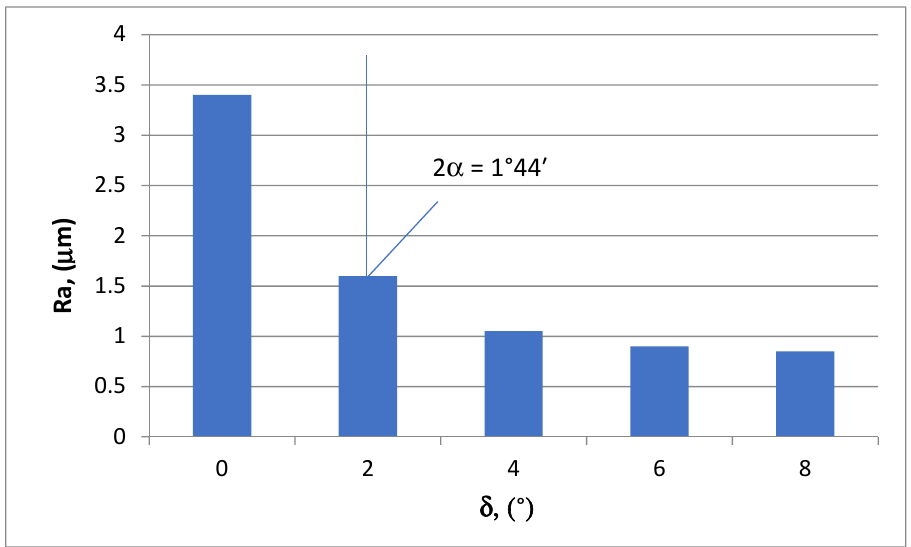
Figure 8. Influence of the δ angle of rotation on the worn round insert (r ε = 6mm). Ra is the surface roughness parameter.